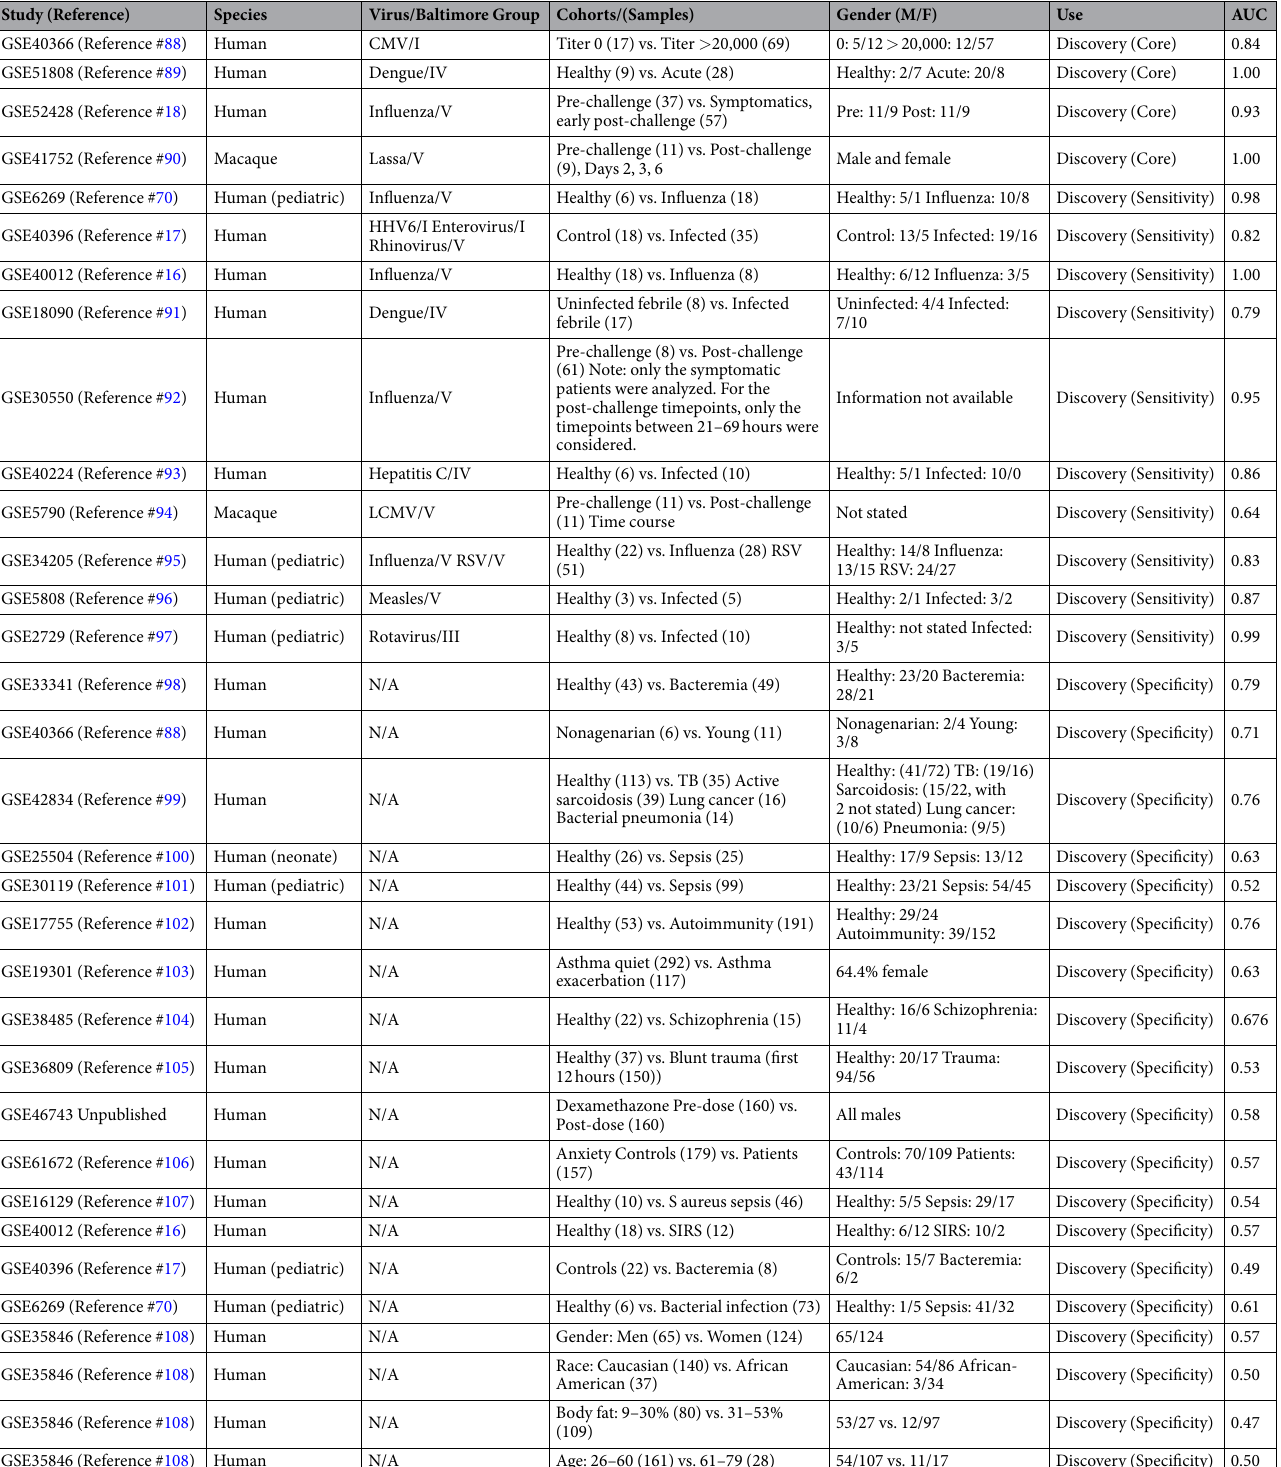
Table 1. Discovery datasets used in this study. Details of datasets used for discovery of the pan-viral signature are listed including: an associated reference (if available), species studied, virus types represented, cohorts compared and the number of samples in each, gender numbers, how the dataset was used, and the performance (AUC) of the pan-viral signature in the cohorts described. Sample type analyzed was blood for all datasets in this